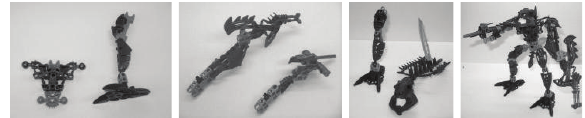
Figure 1: Lego tasks and final object (far